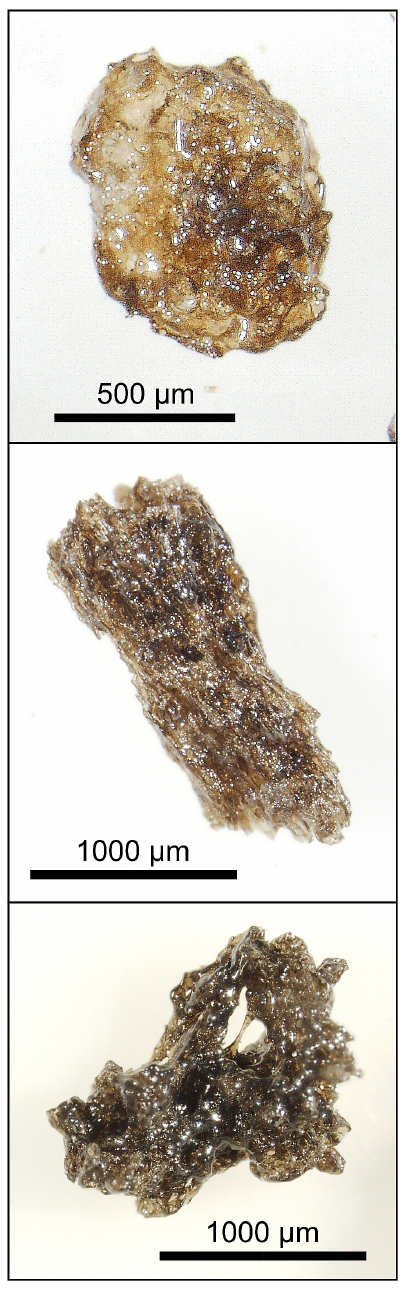
Figure 5. Binocular microscope images showing different morpho- logical types of ash particles from NSEC2 (a, b) and NSEC3 (c)